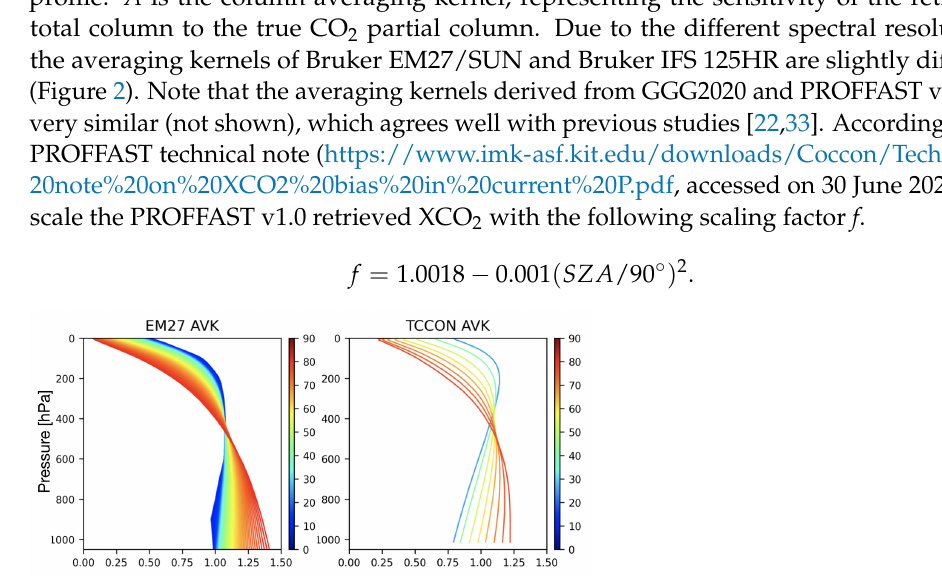
Figure 2. The column averaging kernels of Bruker EM27/SUN ( left ) and Bruker IFS 125HR ( right ) CO 2 retrievals varying with the solar zenith angle, which are both analysed by the GGG2020